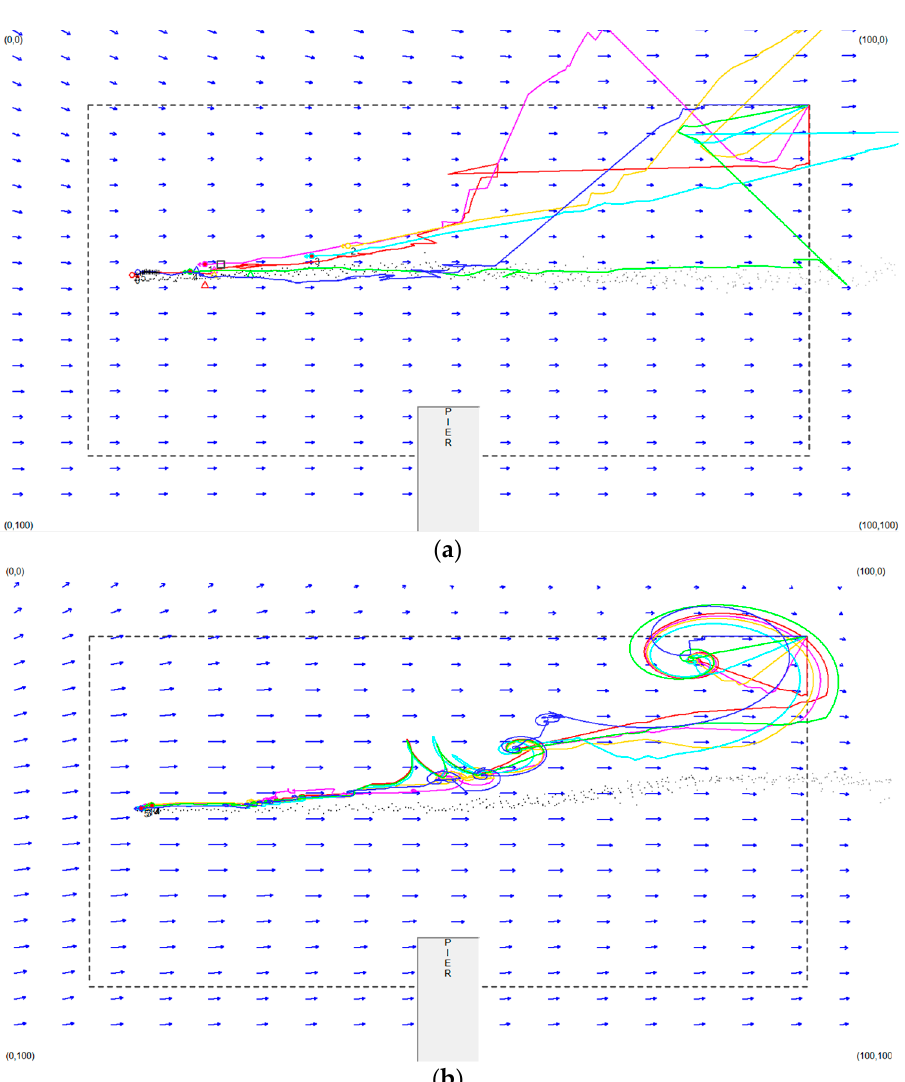
Figure 7. Typical paths generated by the uGA and SS methods. Paths in different colors belong to different SNs. ( a ) Typical paths of the uGA method; ( b ) typical paths of the SS method. The straight-line paths generated by uGA helped in reducing the path length for reacquiring the plume, since the shortest distance between two points is a straight